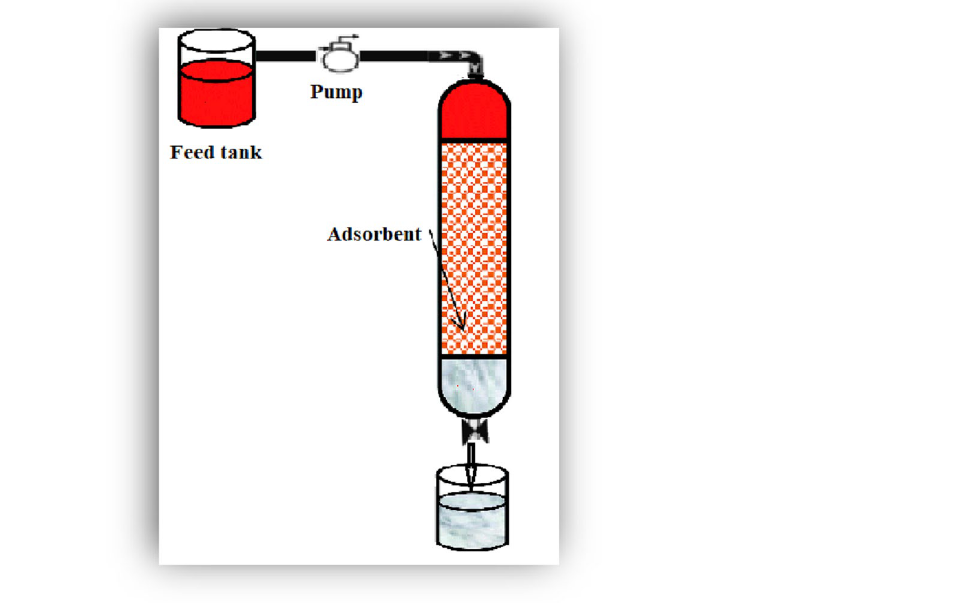
Figure 1. The continuous adsorption